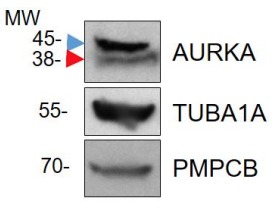
Total lysates from HEK293 cells obtained by immediate lysis in Laemmli sample buffer.Cells were blotted for endogenous AURKA, TUBA1A and PMPCB. AURKA46 and AURKA38 are indicated with a blue and red arrowhead, respectively.